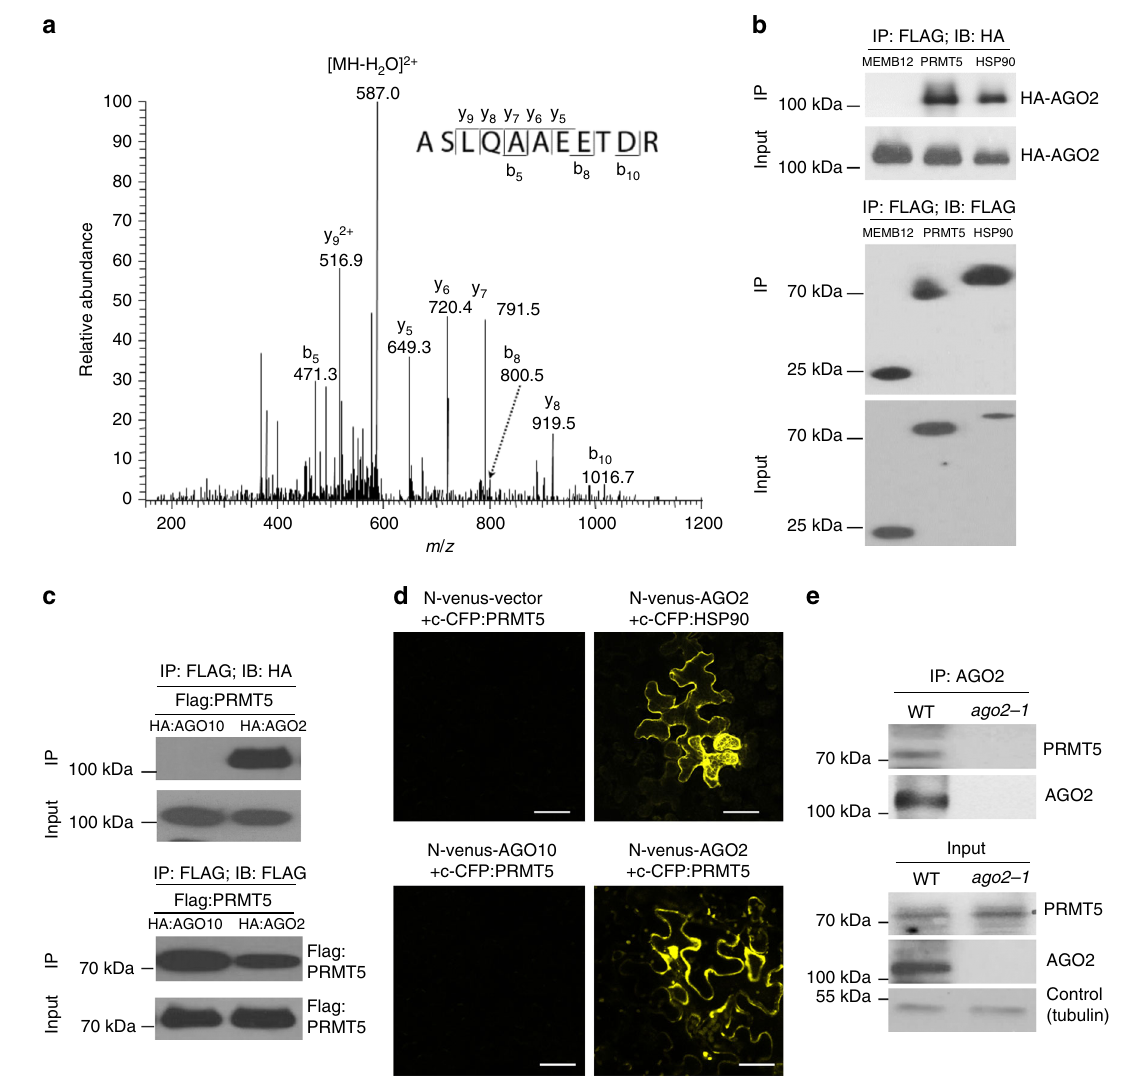
Fig. 1 PRMT5 interacts with AGO2. a Representative MS/MS of the [M + 2 H] 2 + ion of a PRMT peptide identi fi ed from co-immunoprecipitated (IP) complexes associated with HA-tagged AGO2 (HA:AGO2). Displayed in the inset is a scheme summarizing the observed fragment ions for the peptide. b Association of Arabidopsis PRMT5 and AGO2 was detected in a co-IP assay when transiently expressed in Nicotiana benthamiana . HA:AGO2 was transiently expressed along with Flag:PRMT5, Flag:HSP90 (positive interaction control), or Flag:MEMB12 (negative interaction control) in Nicotiana benthamiana . Protein complexes were immunoprecipitated using anti-Flag antibody to pull down PRMT5 and probed with antibodies against Flag or HA tags. c Flag:PRMT5 interacts only with HA:AGO2 but not with HA:AGO10. Protein complexes were immunoprecipitated using anti-Flag antibody and probed with antibodies against Flag or HA tags after being transiently expressed in N. benthamiana . d Bimolecular fl uorescence complementation assay in N. benthamiana leaf epidermal cells shows that N-venus:AGO2 interacts with c-CFP:PRMT5. Yellow fl uorescence is not reconstituted in the absence of an interacting bait protein (negative control, left upper panel) or using N-venus:AGO10 as a bait protein (negative control, left bottom panel), while fl uorescence is observed when co-expression of N-venus:AGO2 with c-CFP:HSP90 (positive control, right upper panel) and c-CFP:PRMT5. The scale bar represents 50 µ m. e Association of PRMT5 and AGO2 was observed in vivo in the wild-type (WT) Arabidopsis thaliana plants (Col-0), but not in the ago2-1 mutant by the co-IP assay. Native antibodies to AGO2 and PRMT5 were used to pull down AGO2 and detect PRMT5, respectively. Tubulin was used to show equal protein